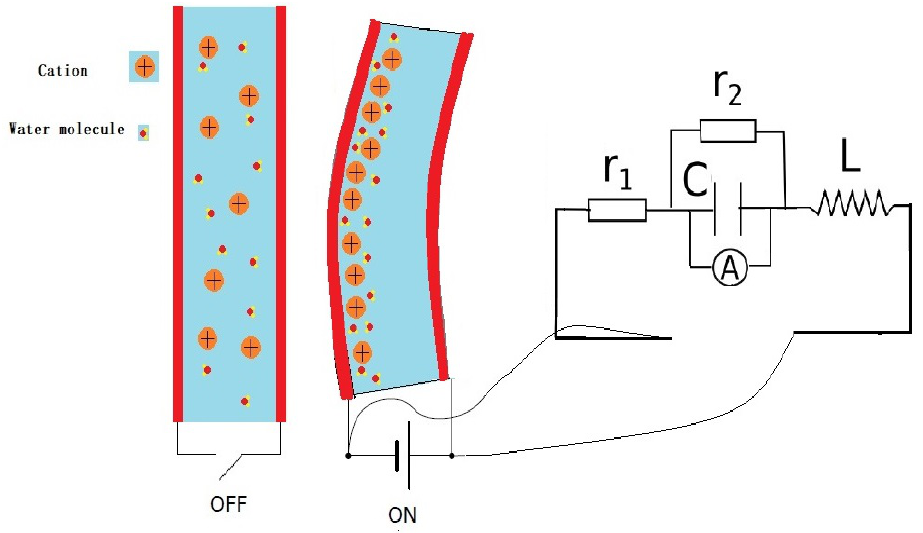
Figure 2. Physical structure of the IPMC actuator and its electrical